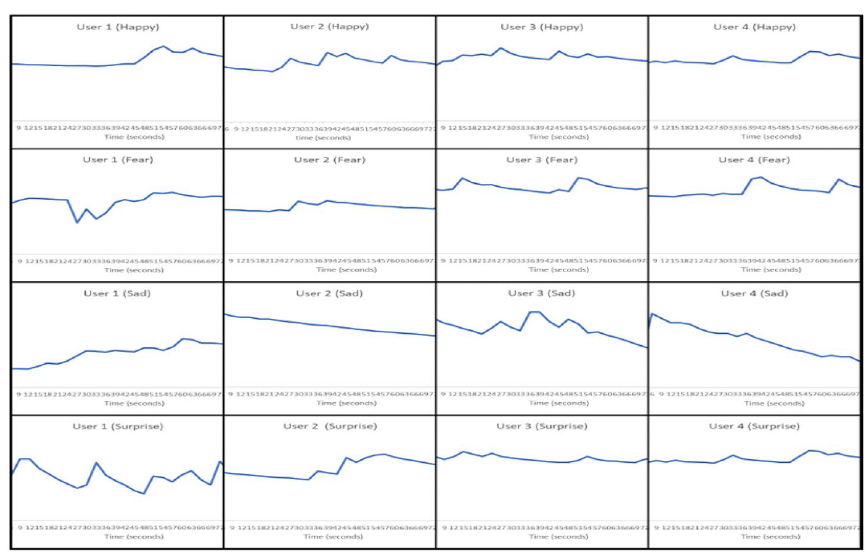
Fig. 13 Experimentation to capture the patterns of GSR output on different participants with stimuli